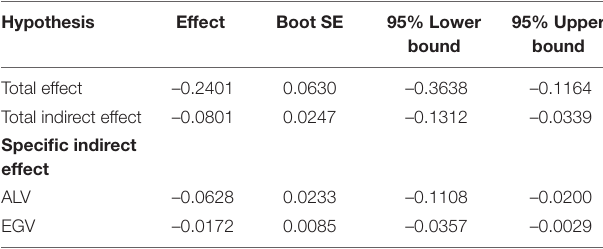
TABLE 4 | Results for the mediation effect test ( N = 977).